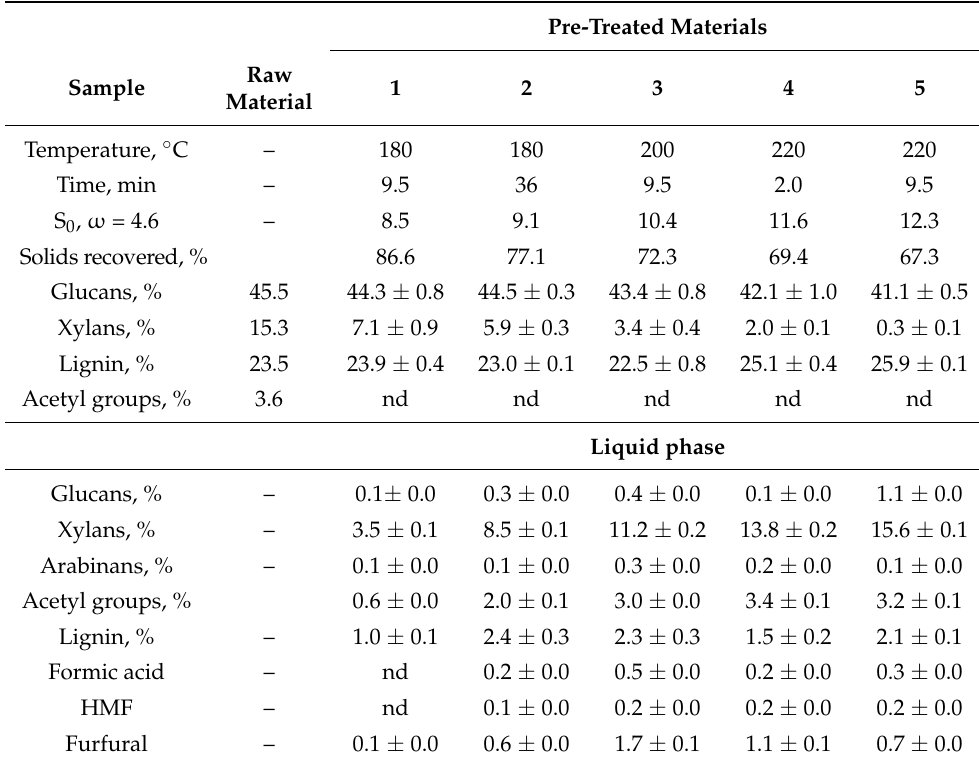
Table 1. Chemical composition of wood, pulps and liquid fractions obtained from steam explosion pre-treatment at different